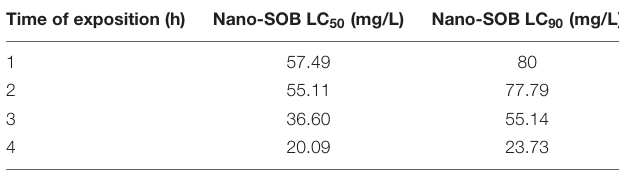
TABLE 2 | Kinetics of nano-SOB toxicity on Schistosoma mansoni cercariae.